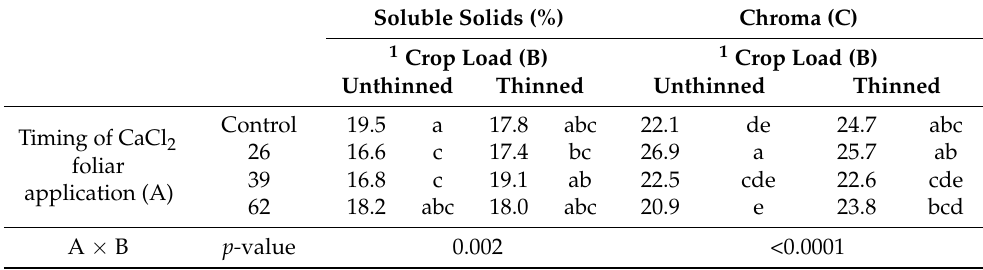
1 Means of 20 fruits/replicate. Different letters indicate significant differences between A × B interaction based on Tukey’s test ( p ≤ 0.05). Control with water only. Of the rheological properties, the timing of the foliar CaCl 2 applications had significant effects on the modulus of elasticity ( p = 0.0001) and energy at the maximum point ( p = 0.006) (Table 6), while the crop load had significant effects on the modulus of elasticity ( p = 0.015), energy at the maximum point ( p < 0.0001), and FIDI ( p = 0.014) (Table 6). Foliar Ca applied on 26 DAFB had a significant positive effect on the modulus of elasticity (2.36 MPa; p < 0.0001), while thinned trees showed a reduction in the modulus of elasticity ( p = 0.015) of fruits (Table